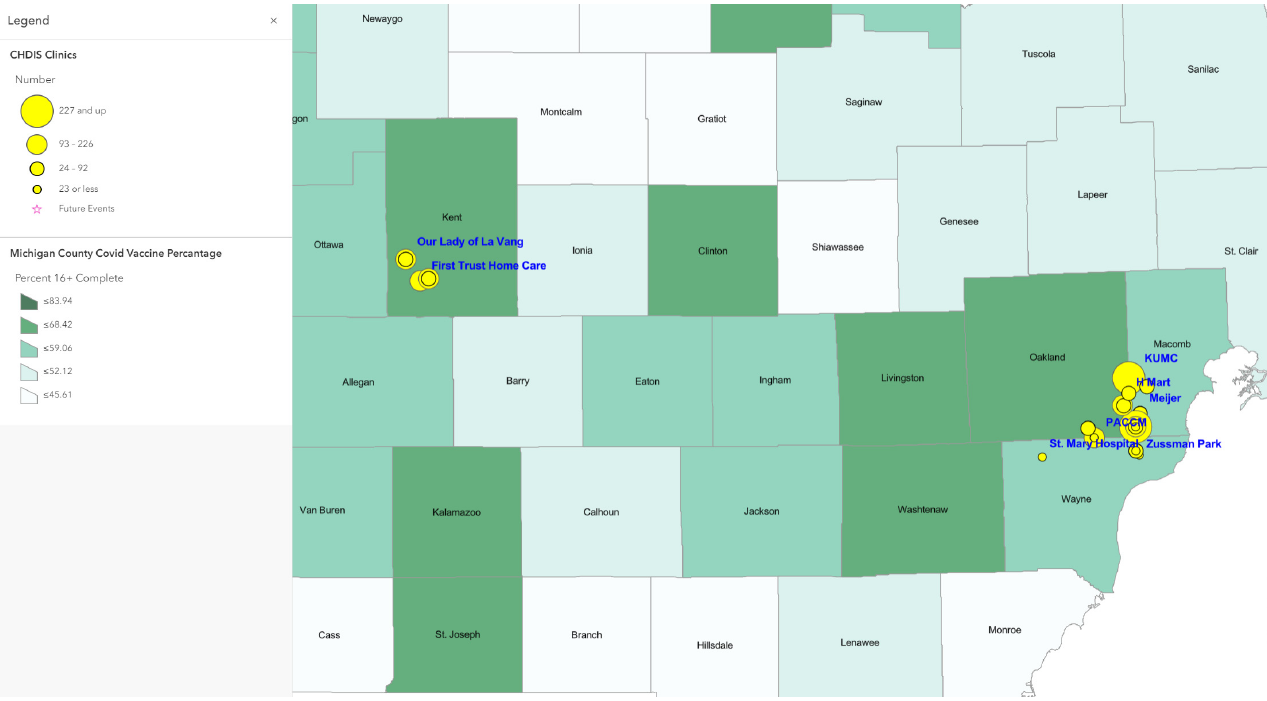
Figure 3. EMU mobile clinics vs. Michigan overall population COVID-19 vaccine completion percentage by county.